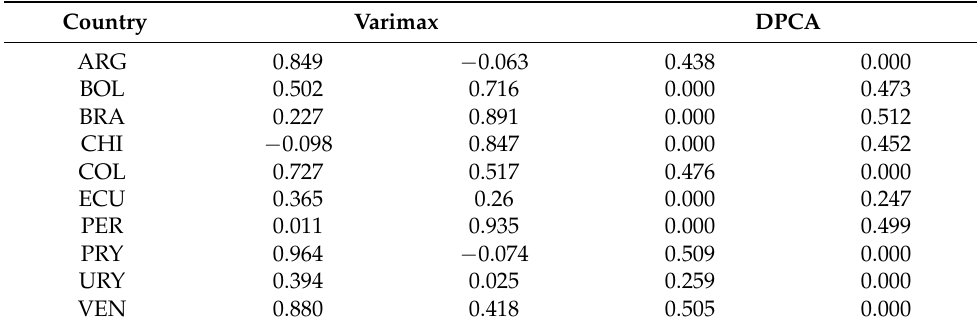
Table 5. Loading matrices for data on the number of COVID deaths with two components for the indicated country and method.